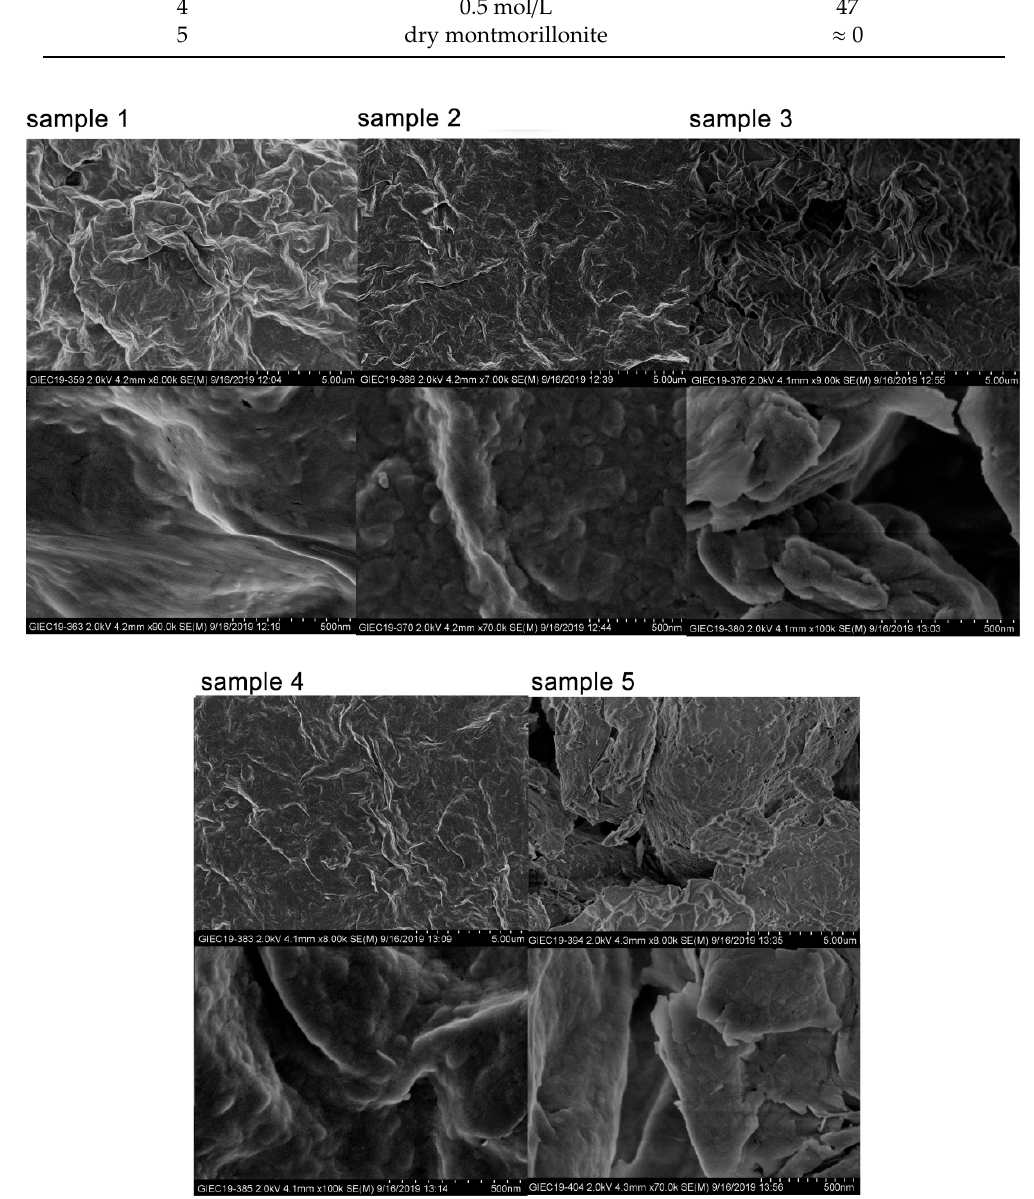
Figure 5. SEM images of samples.